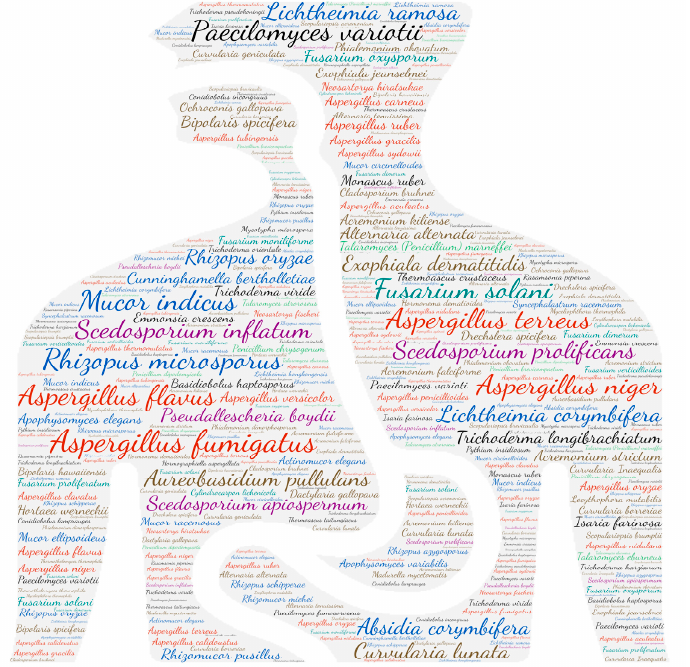
Figure 9. Wordcloud represents the species name isolated in the digestive system. The size of the name of each species is proportional to the number of times it occurs in the repertoire. Invasive bowel infections by Aspergillus and mucorales (14 and 9 publications, respec- tively) are mainly reported concomitantly with disseminated infection. Invasion of the gastrointestinal tract is rarely described individually